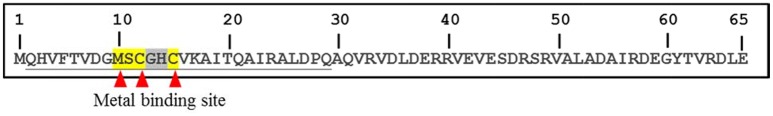
The metal binding site prediction in 65aa peptide by BLAST.